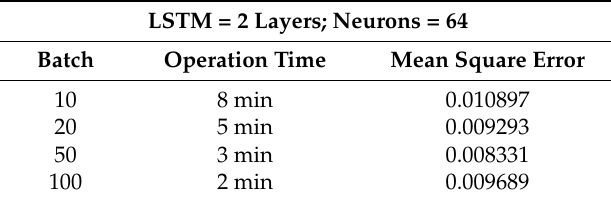
Figure 7. Comparison of batch size fitting effects. Table 1. Batch size prediction results.